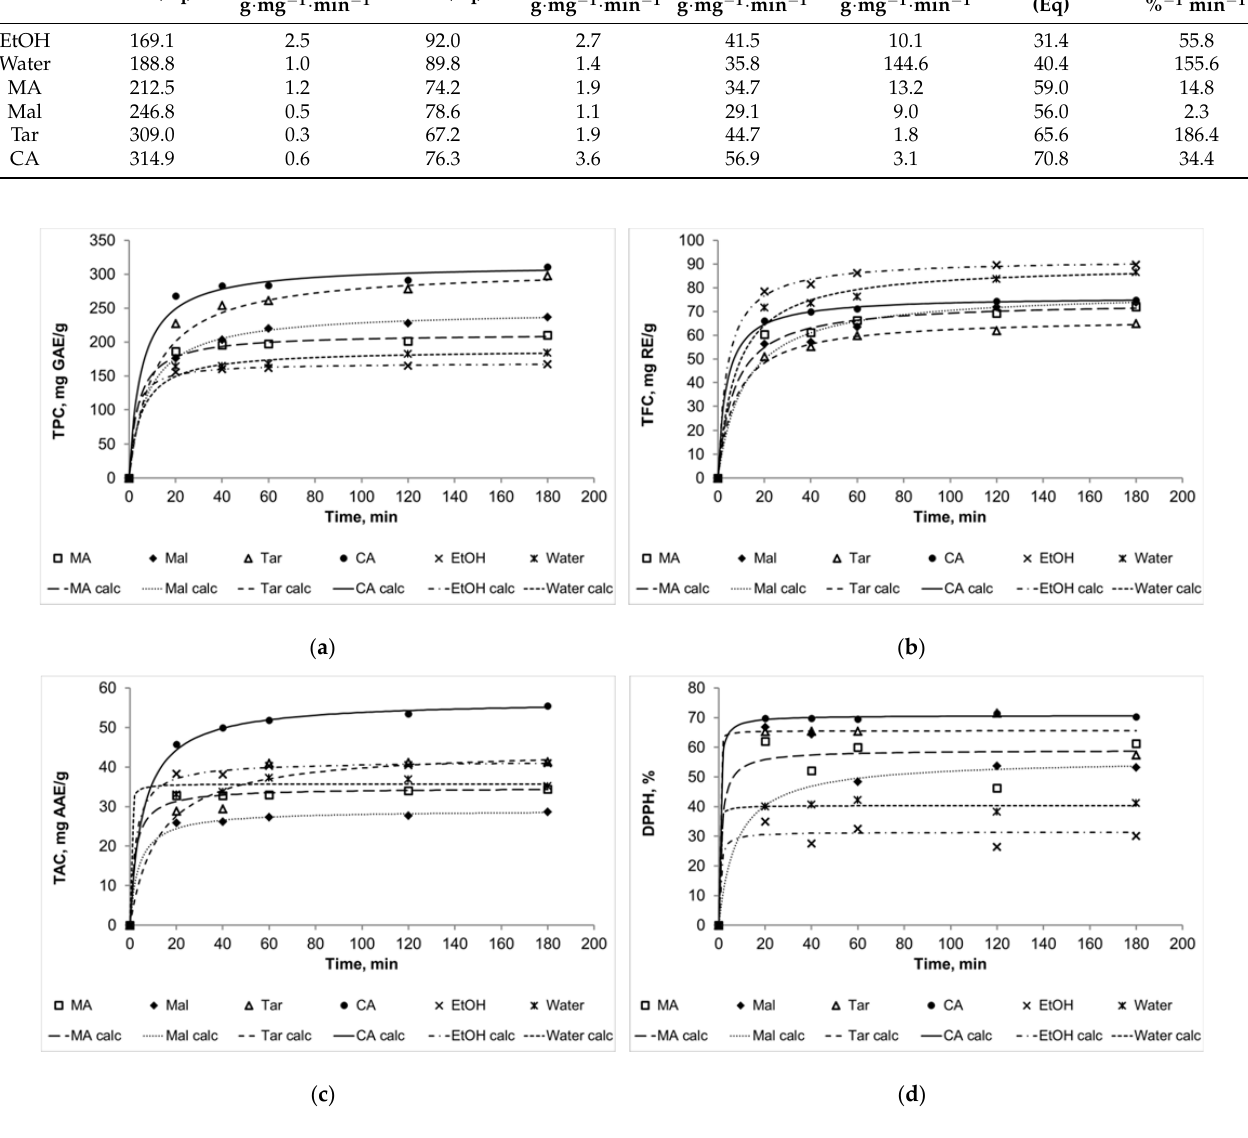
Figure 2. The kinetic curves for TPC ( a ), TFC ( b ), TAC ( c ), and DPPH ( d ). MA: NADES choline chloride + malonic acid, Mal: NADES choline chloride + malic acid, Tar: NADES choline chloride + tartaric acid, CA: NADES choline chloride + citric acid, EtOH: 90%( v / v ) ethanol; “calc” means calculated data.